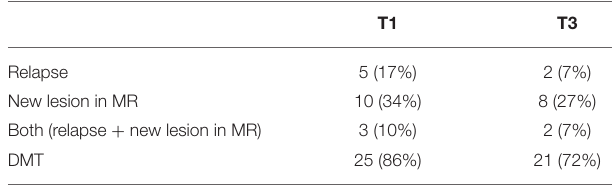
TABLE 2 | The clinical characteristics of the longitudinal assessment study